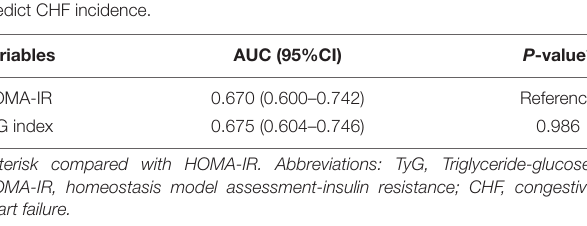
TABLE 3 | The area under the curve (AUC) of the TyG index and HOMA-IR to predict CHF incidence. Variables HOMA-IR